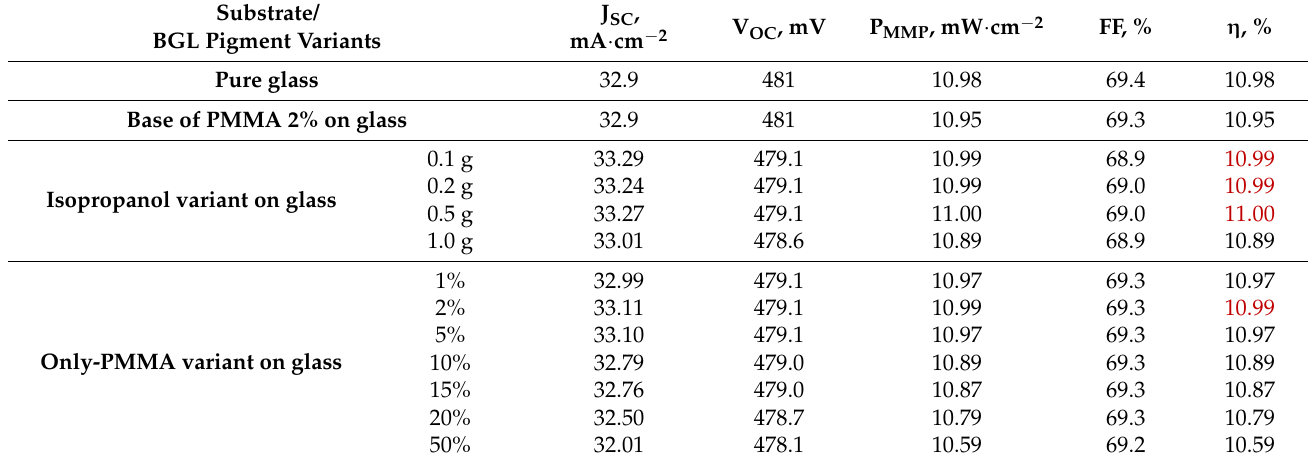
Table 3. The characteristic value of the model of photovoltaic panel without and with layers based on BGL by spray-coating deposition method in two variants.